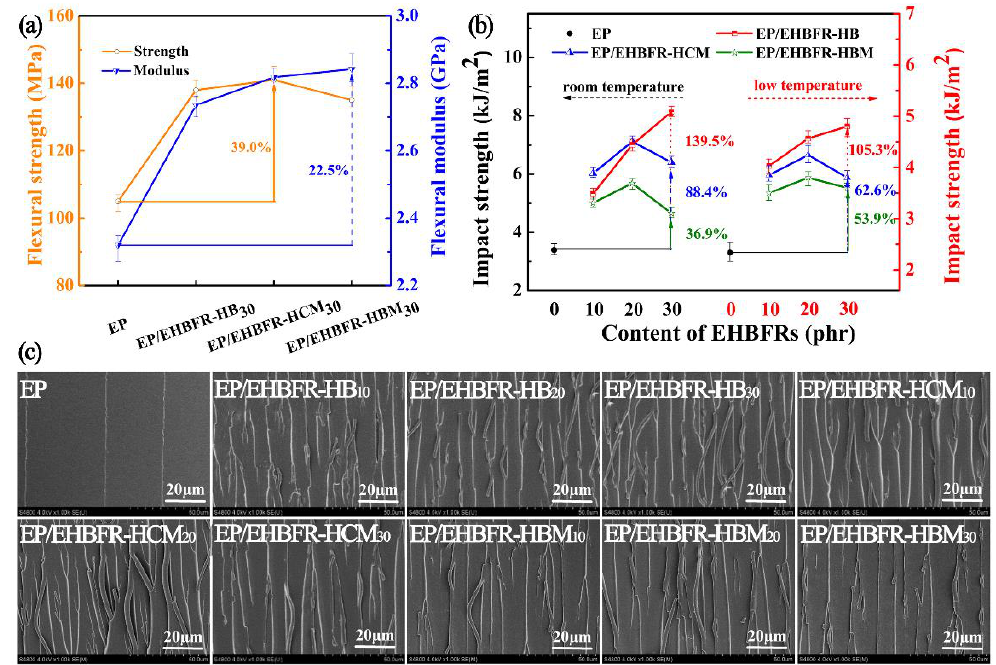
Figure 5. Flexural properties ( a ), impact strength ( b ) and SEM images of fracture surfaces ( c ) for epoxy thermosets after impact strength tests.